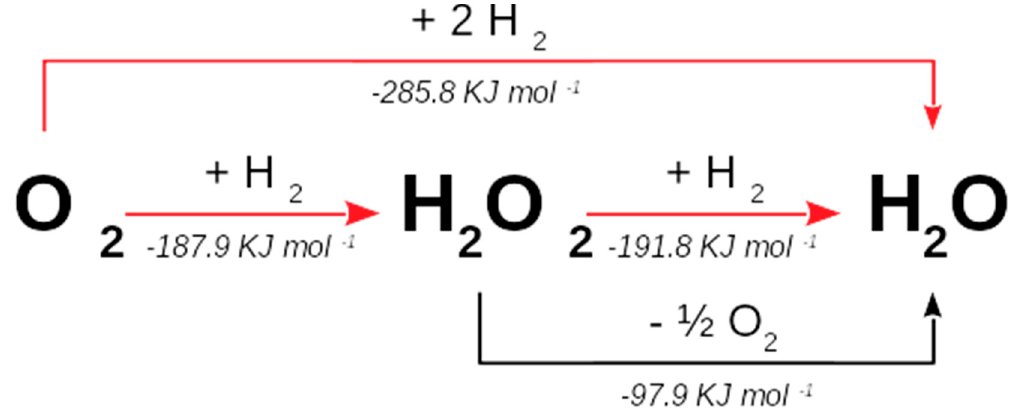
Figure 1. Reaction scheme for the DS of H 2 O 2 from its elements with standard reaction enthalpy data (25 °C).